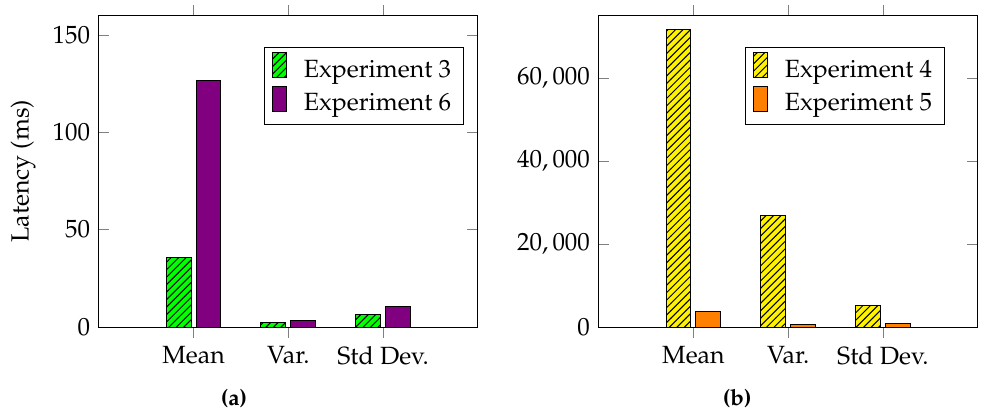
Figure 8. Experiments 3, 4, 5, and 6—Latency statistics for SDN components ( a ) and for the IOTA network ( b